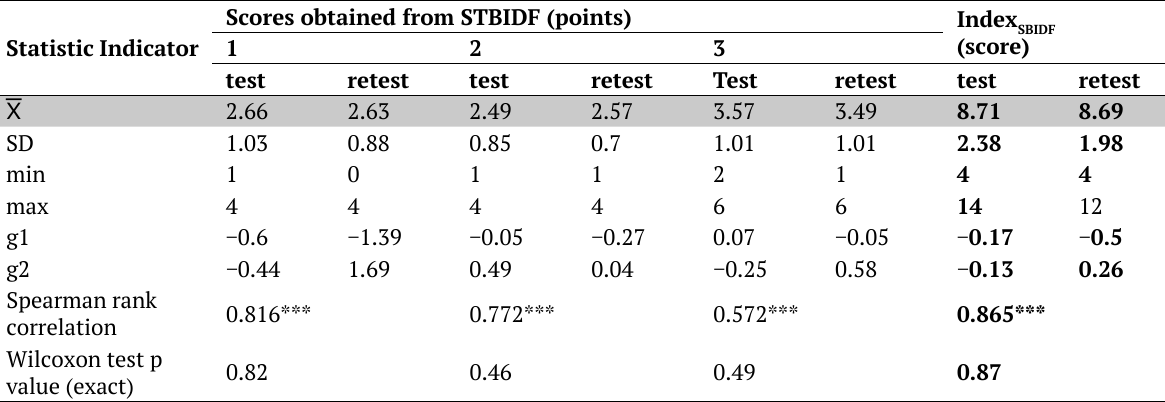
Table 3. Mean scores of STBIDF (test-retest) after all experts’ corrections.